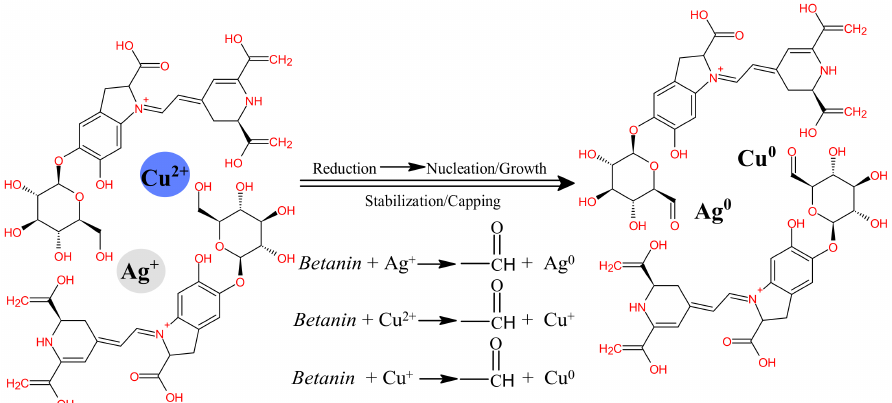
Scheme 1. Proposed mechanism of Ag-Cu bimetallic nanoparticle formation using Beta vulgaris aqueous